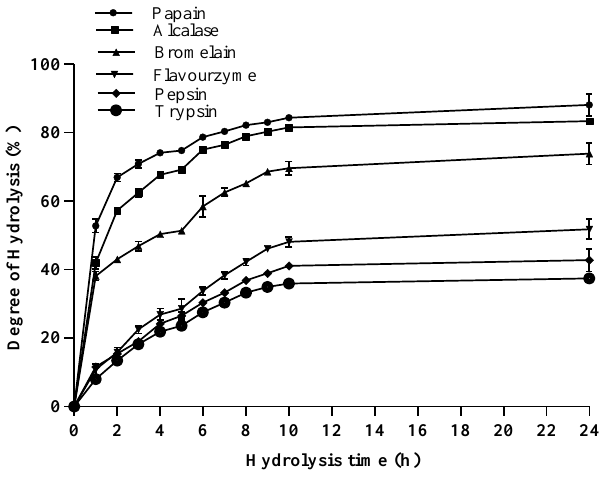
Figure 1. Degree of hydrolysis of A. lecanora , hydrolyzed by different proteolytic enzymes. Results are the average of triplicate determinations (mean ±